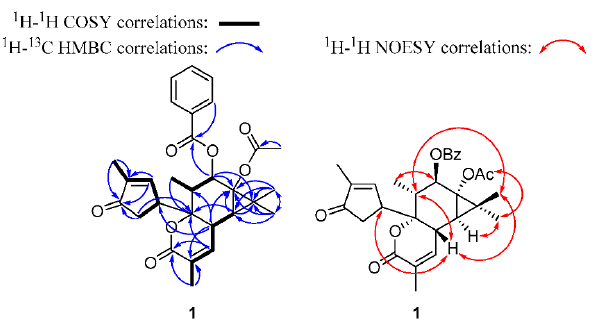
Figure 3. The 1 H- 1 H COSY, key HMBC, and NOESY correlations of compound 1 .